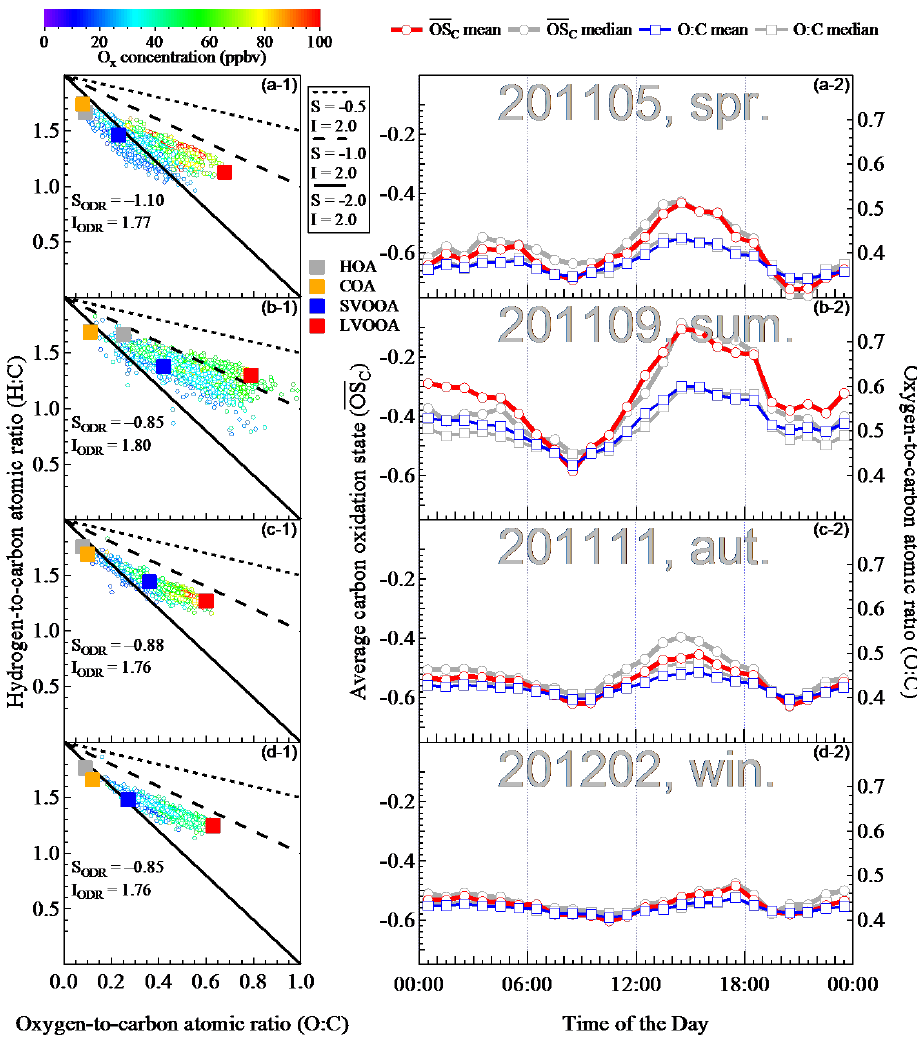
Figure 5. Summary of the degrees of oxygenation of organics in the 4 months. The left panels are the van Krevelen diagrams showing the H:C vs O:C ratios. Small open circles, representing the individual data points, were color-coded by O x concentration. Large solid squares are the average H:C and O:C ratios of the factors from PMF analysis. S ODR and I ODR are slopes and intercepts from orthogonal distance regression (ODR). Three lines with an intercept (I) of 2.0 and slopes (S) of − 0.5, − 1.0, and − 2.0 are also added for reference. The right panels are the diurnal patterns of average carbon oxidation state ( OS C ) and the O:C ratio.